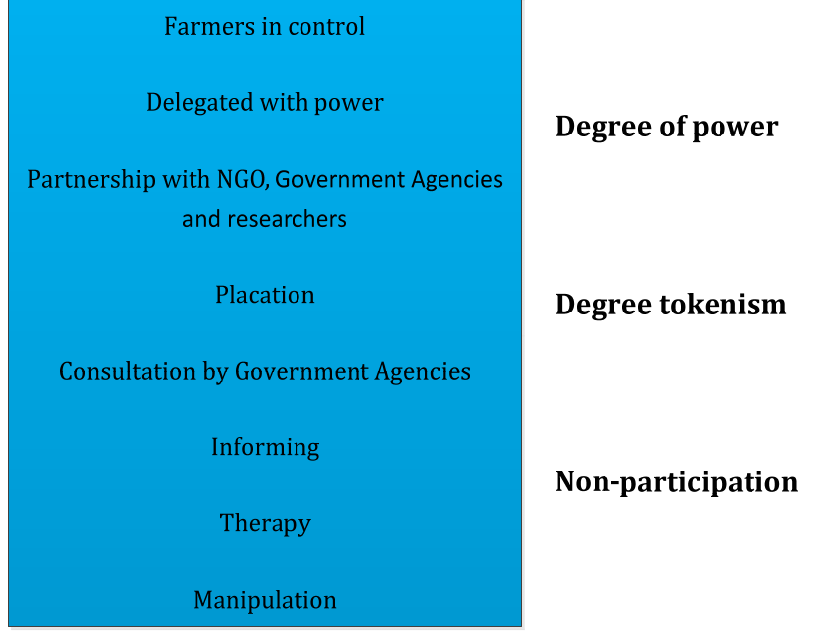
Figure 7. Degree of participation for managing groundwater (adapted from Arnstein,